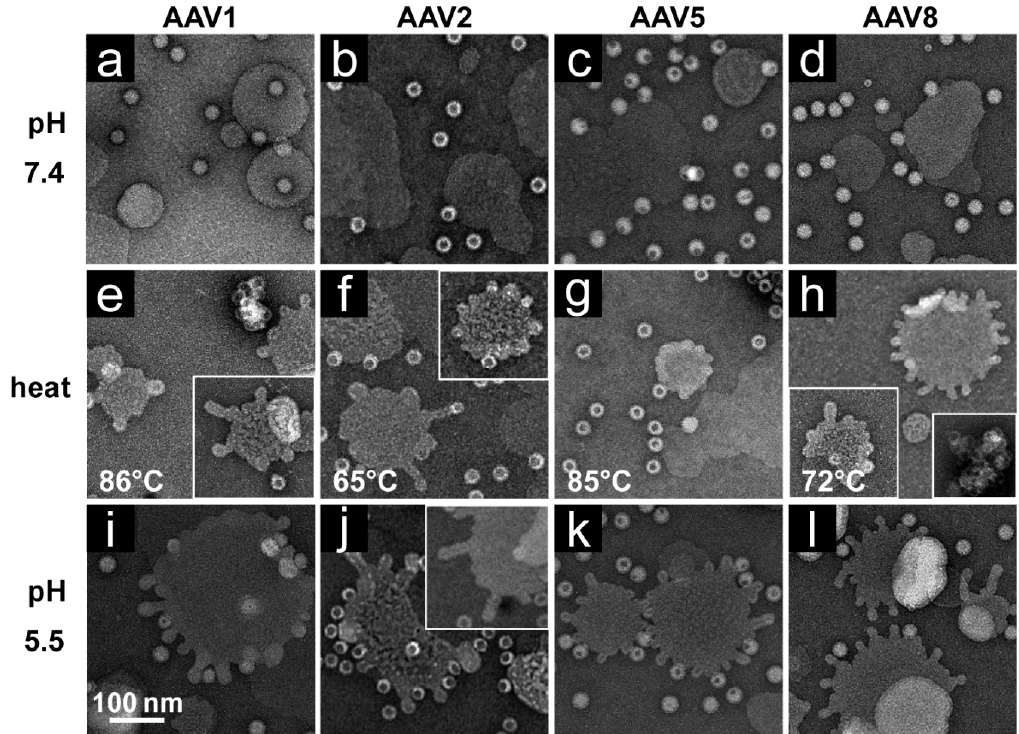
Figure 6. AAV–liposome interactions. POPC liposomes in presence of ( a ) rAAV1-GFP, ( b ) AAV2- VLPs, ( c ) rAAV5-GFP, and ( d ) rAAV8-GFP at pH 7.4. POPC liposomes in presence of ( e ) rAAV1-GFP, ( f ) AAV2-VLPs, ( g ) rAAV5-GFP, and ( h ) rAAV8-GFP that were heat-shocked prior to addition to liposomes. POPC liposomes in presence of ( i ) rAAV1-GFP, ( j ) AAV2-VLPs, ( k ) rAAV5-GFP, and ( l ) rAAV8-GFP that were incubated at pH 5.5 prior to addition to liposomes. Bleb formation of POPC liposomes was observed in ( e – l ). All experiments were performed in triplicate. Viruses 2020 , 12 , x FOR PEER REVIEW